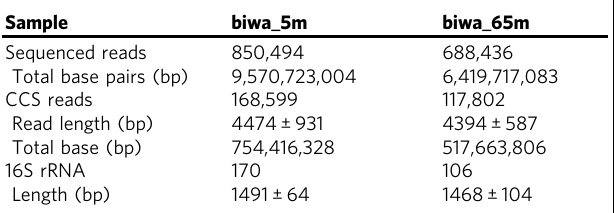
Table 1 Statistics of SMRT sequencing and